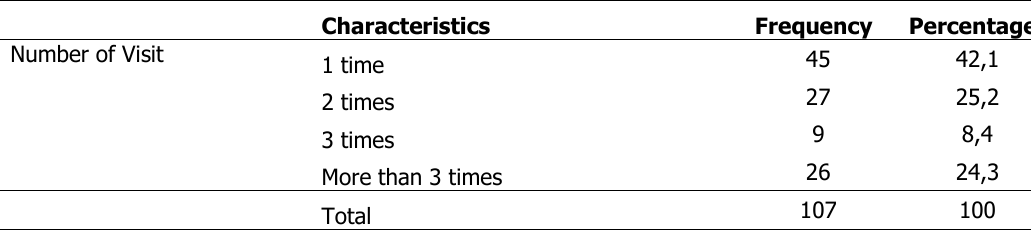
Table 6. Demographic Characteristics of Observations Based on Number of